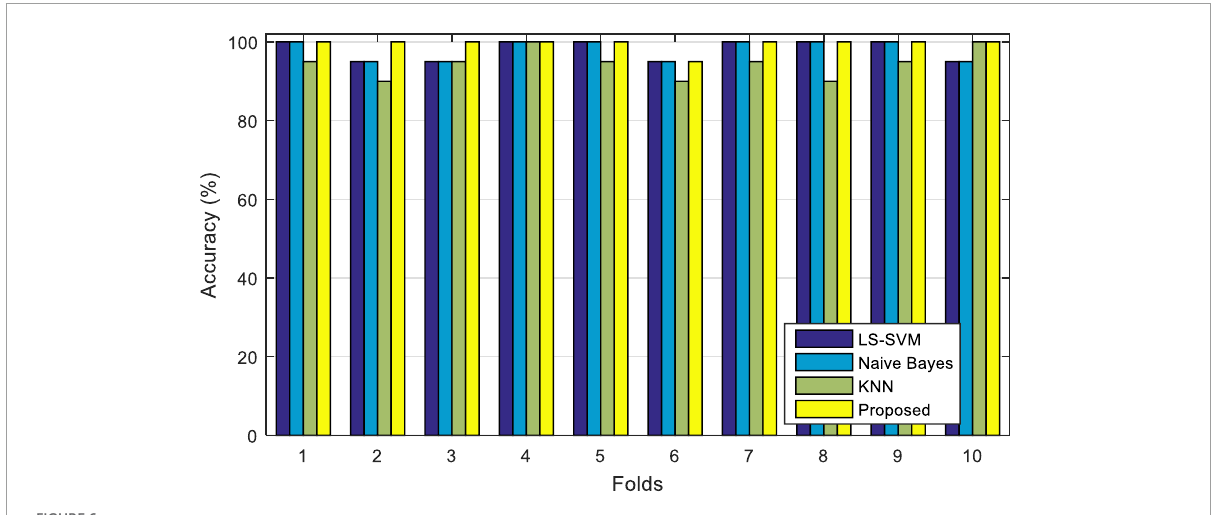
FIGURE6 Accuracy of correct diagnosis of the proposed method in comparison with the algorithms used in it.